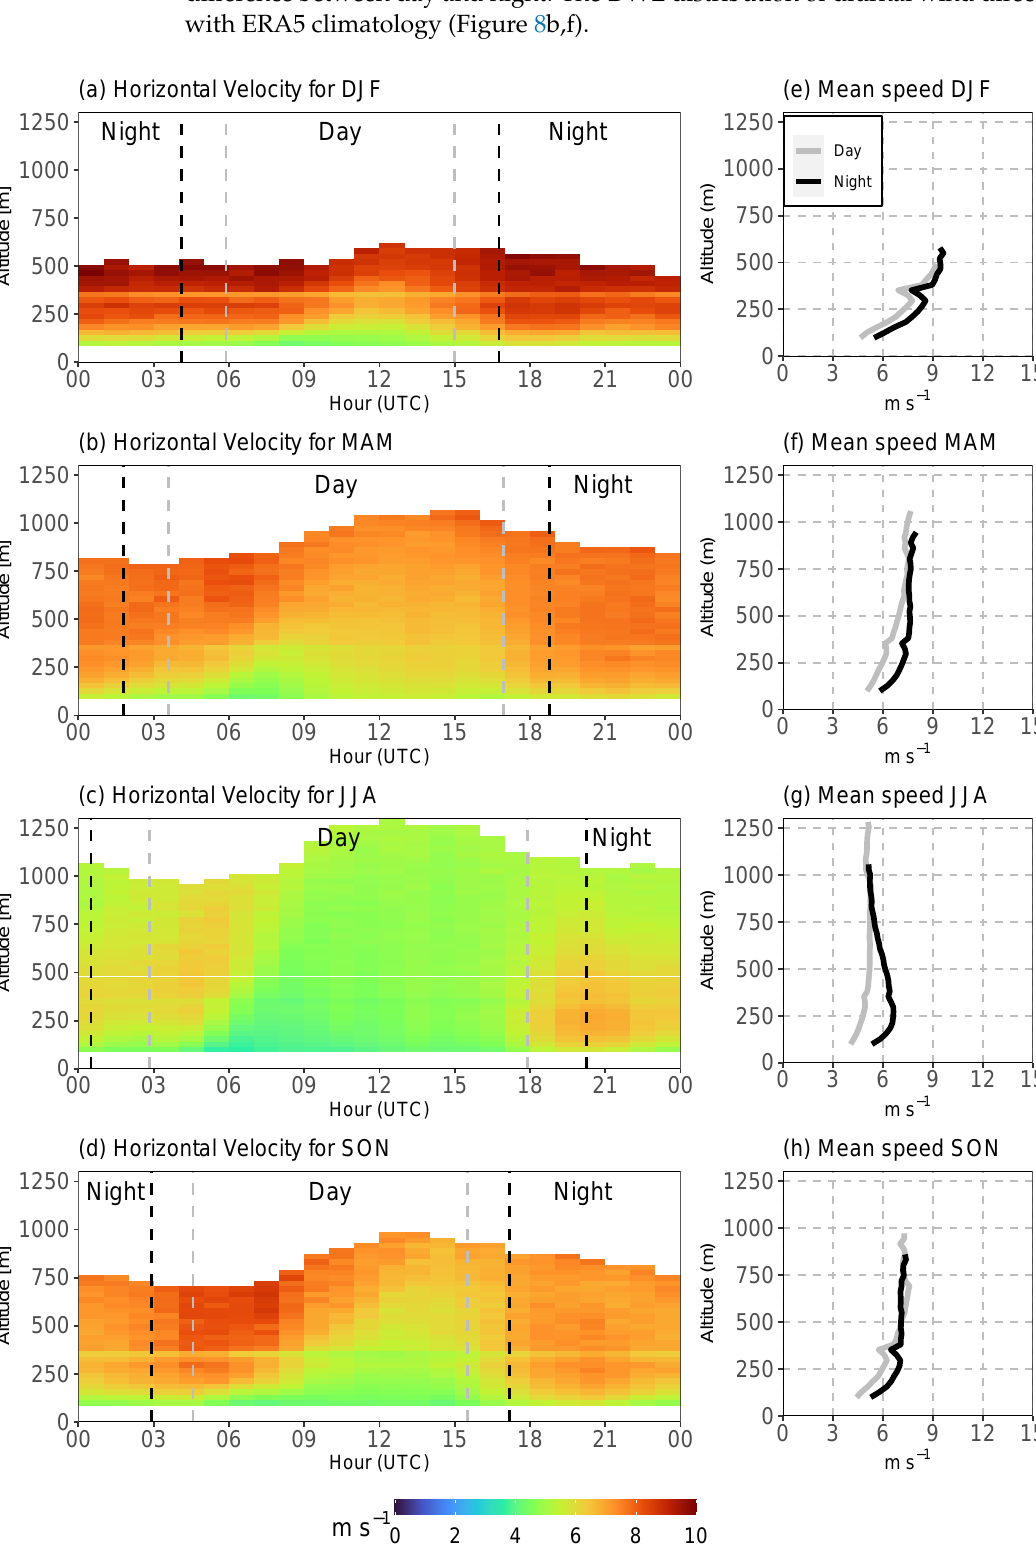
Figure 5. DWL hourly means of horizontal wind speeds for December 2019–November 2021 analysed period for all seasons ( a – d ) and the mean speed profiles for daytime and nighttime ( e – h